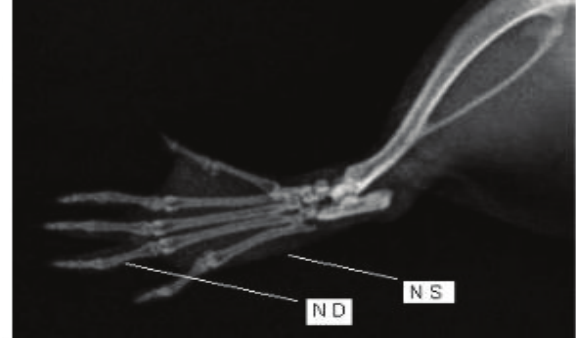
Fig-3: Prophylactic Group 3 Naproxen treated rats shows no swelling (NS) of hind paw and no deformity (ND) of interphalangeal joints.